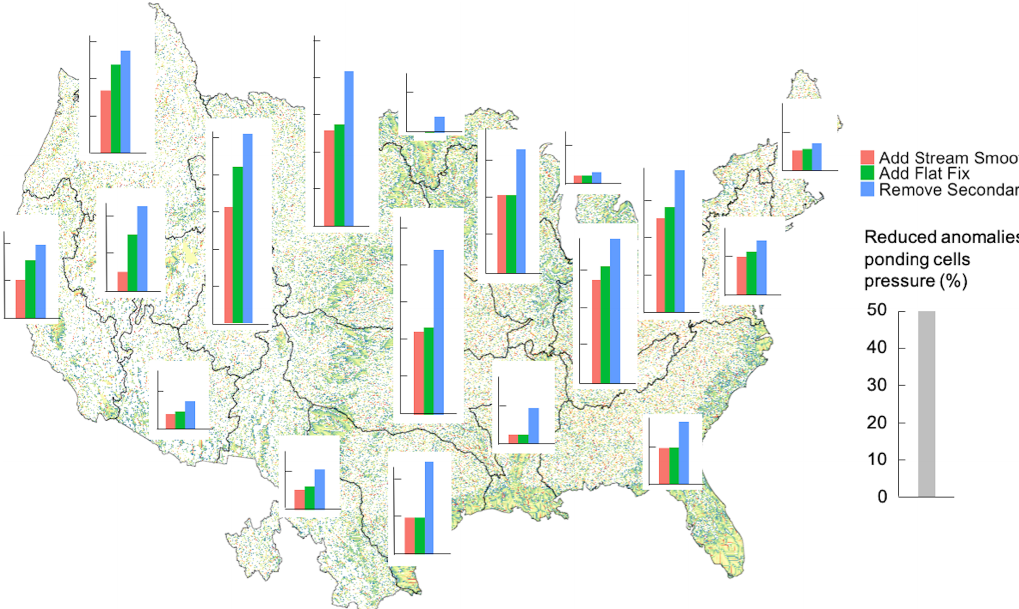
Figure 10. The background map is the ponding depth from runoff test at hour 20 with the final slope; barplots are the percentage decrease of anomalies’ ponding cells (ponding depth over 0.1m) outside the main stream network relative to the baseline (no smooth case) in HUC2s. The scale of the barplot in each HUC is the same, with the grey bar shown in the right of figure.